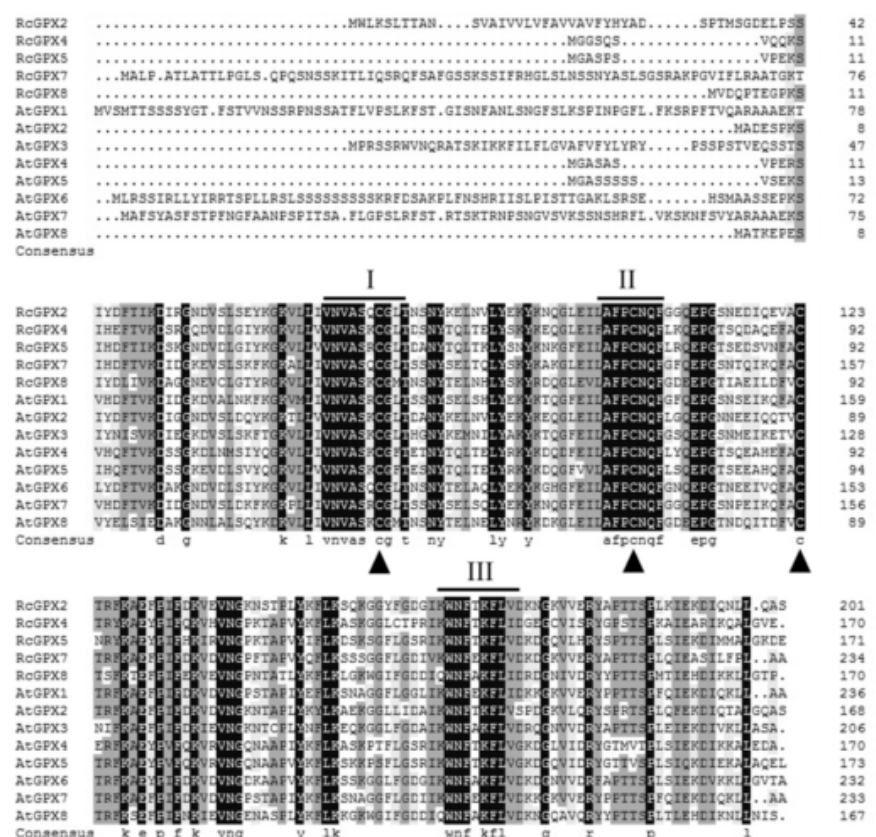
Figure 1. Amino acid sequences alignment of plant glutathione peroxidase by DNAMAN. The highly conserved domains were presented by line and digital alphabet I, II, and III The conserved three Cys residues of plant GPX proteins are indicated by triangles. Abbreviations of plant species: Rc, Rhodiola crenualta ; At, Arabidopsis thaliana . The GPX protein sequences of Arabidopsis thaliana were as followed: AtGPX1 (AT2G25080.1); AtGPX2 (AT2G31570.1); AtGPX3 (AT2G43350.1); AtGPX4 (AT2G48150.1); AtGPX5 (AT3G63080.1); AtGPX6 (AT4G11600.1); AtGPX7 (AT4G31870.1); AtGPX8 (AT1G63460.1).